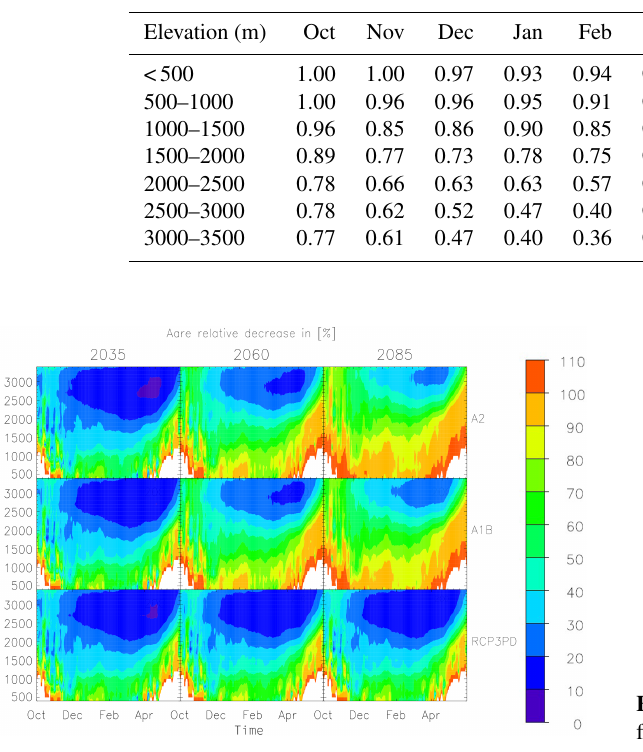
Figure 5. Relative decrease (%) of the snow depth in the Aare re- gion for the three emission scenarios (top, middle, bottom) and the three different time periods (left to right), dependent on season and elevation. The white colors indicate a lack of data.